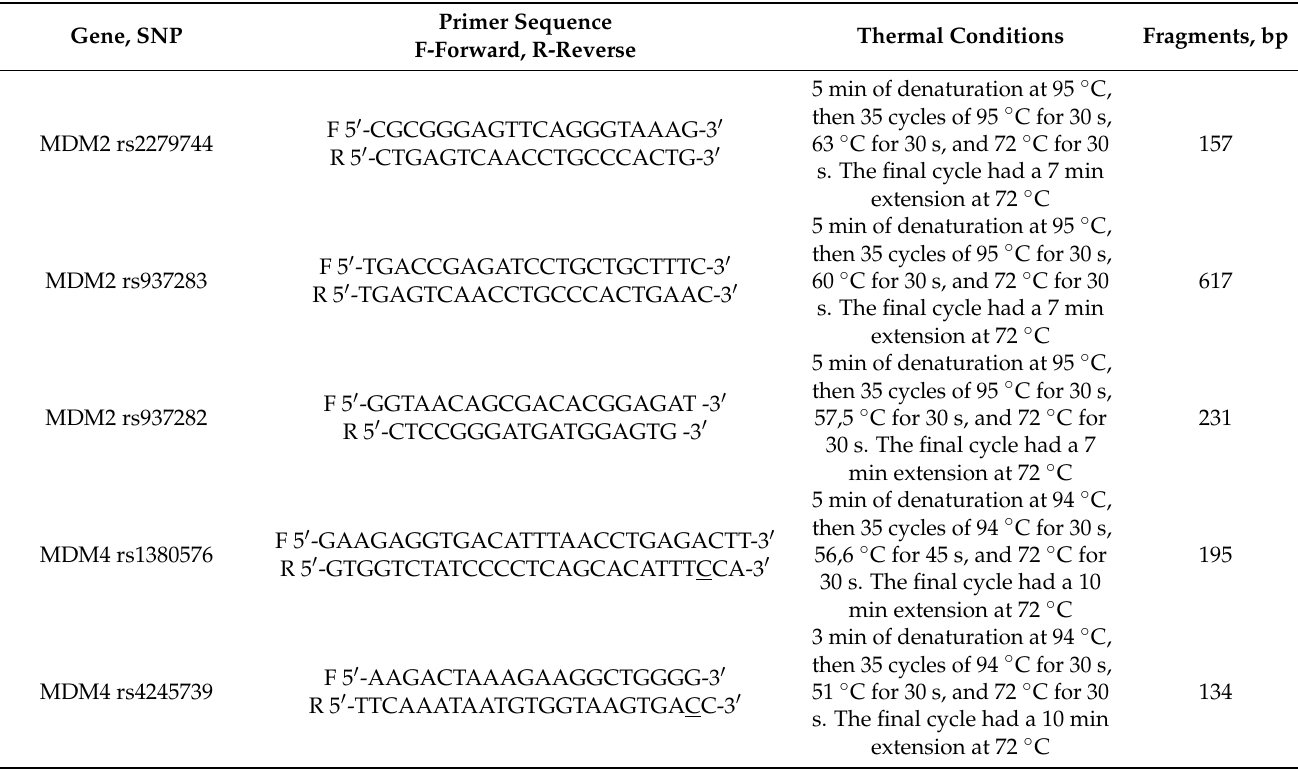
Table 1. The SNP and thermal conditions for analysis.